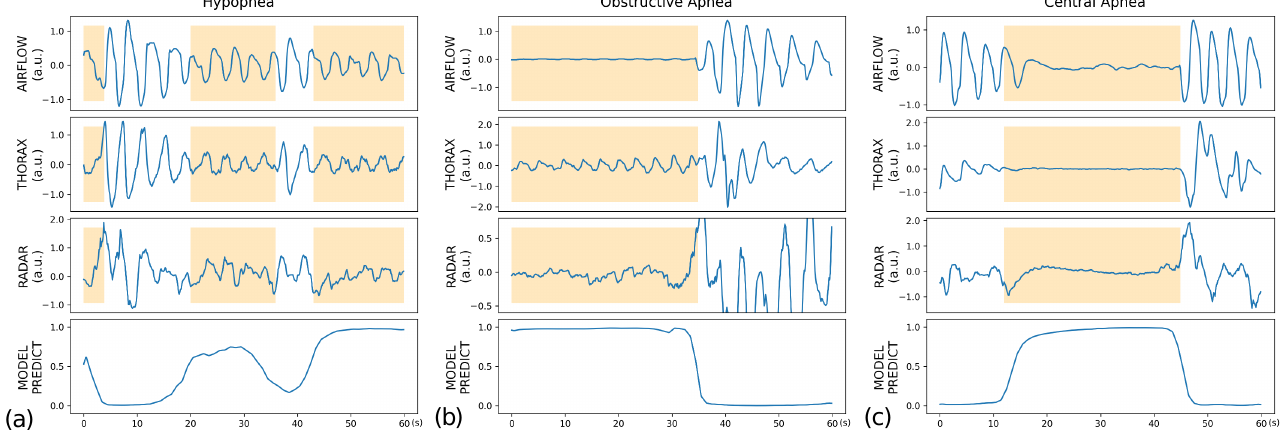
Figure 6. Representative cases of ( a ) hypopnea, ( b ) obstructive apnea, and ( c ) central apnea, pre- sented along with predictions from the binary model. The ground truth events are annotated with orange boxes.